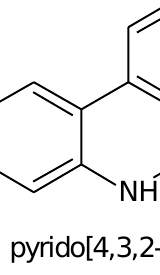
Figure 30. Structure of pyrido[4,3,2- mn ]acridine.